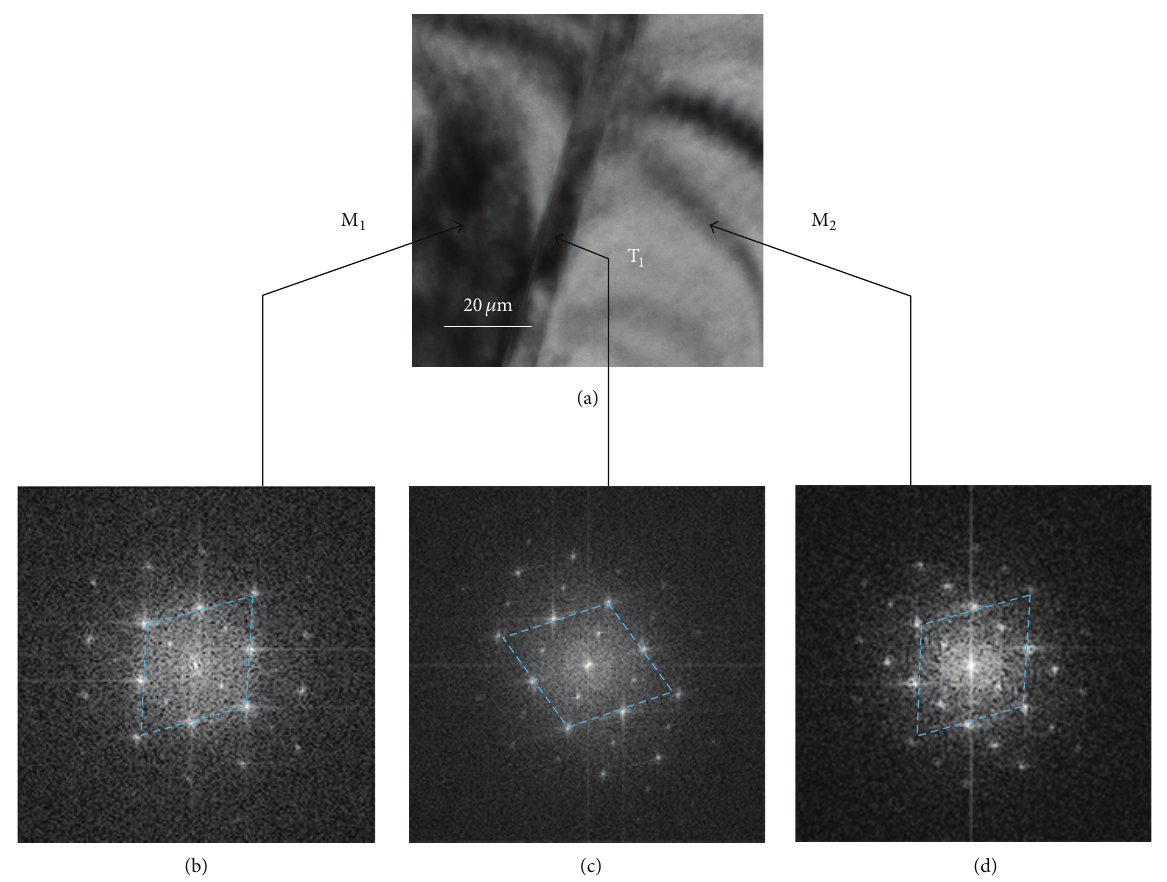
Figure 1: (a) A TEM graph of continuous 𝛾 laths. (b) A HAADF-STEM graph of the same region. (c) A schematic illustration of this